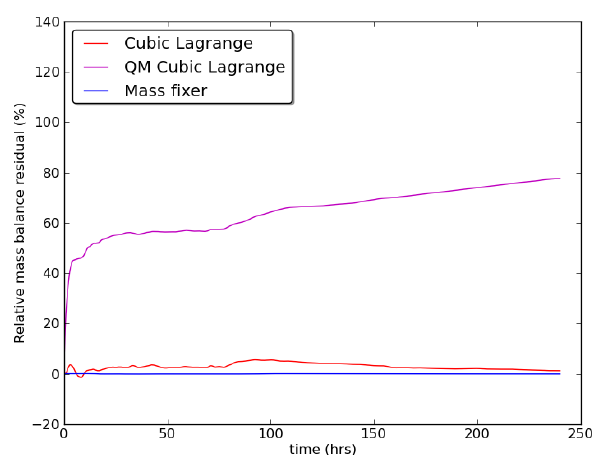
Figure 8. Relative mass residual in volcanic plume simulations (SO 2 ) for different Fig. 8. Relative mass residual in volcanic plume simulations ( SO 2 ) for different schemes